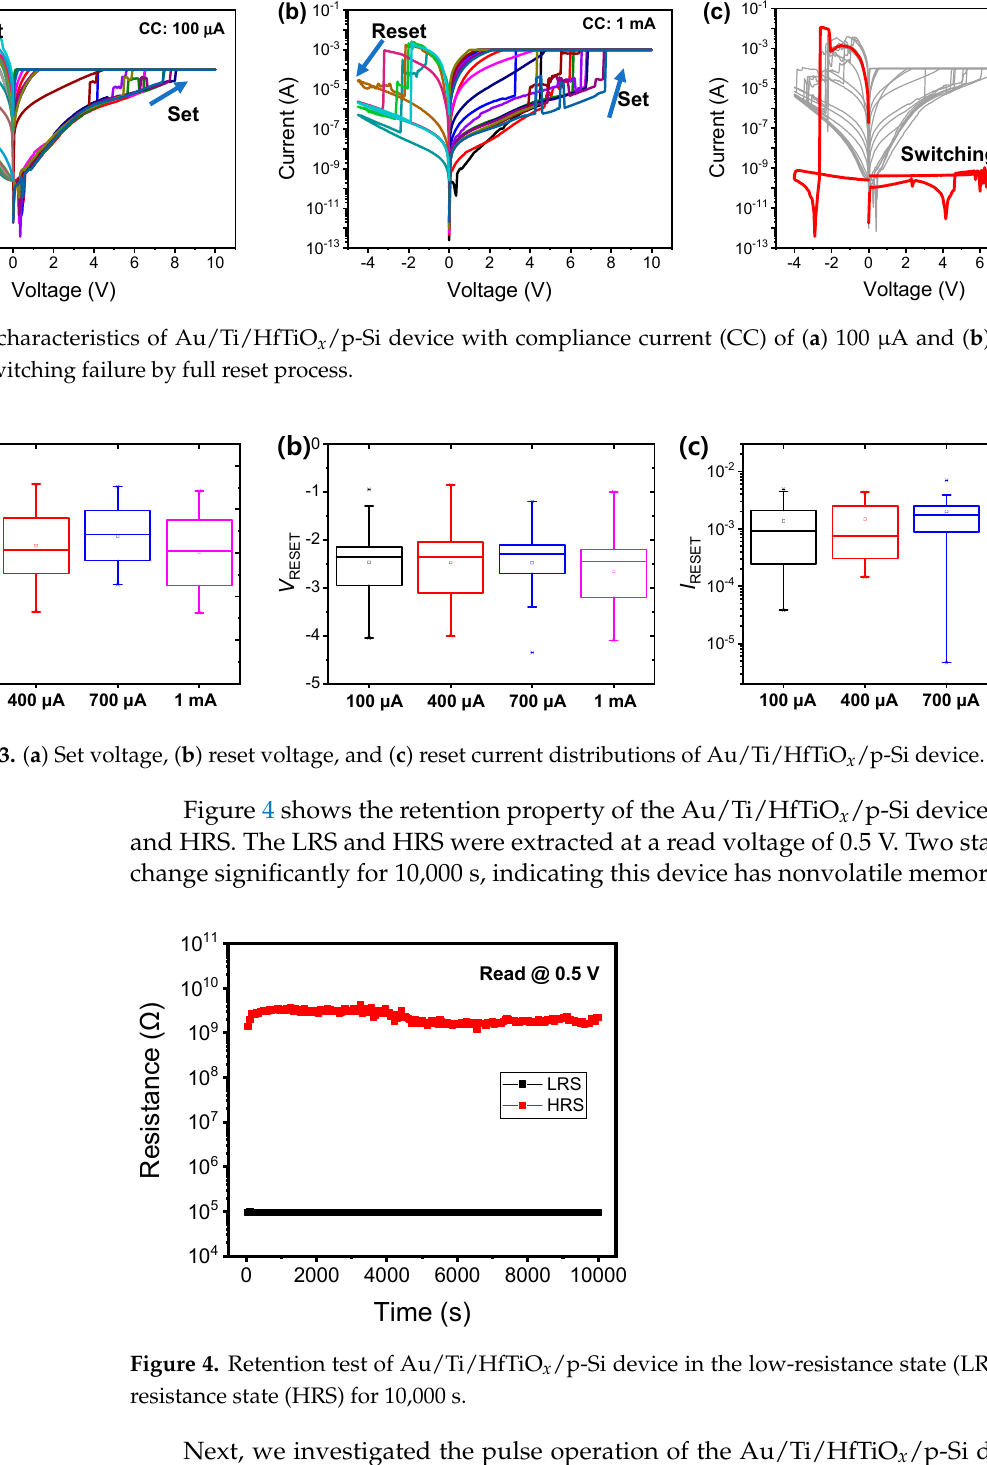
Figure 4. Retention test of Au/Ti/HfTiO x /p-Si device in the low-resistance state (LRS) and high- resistance state (HRS) for 10,000 s.